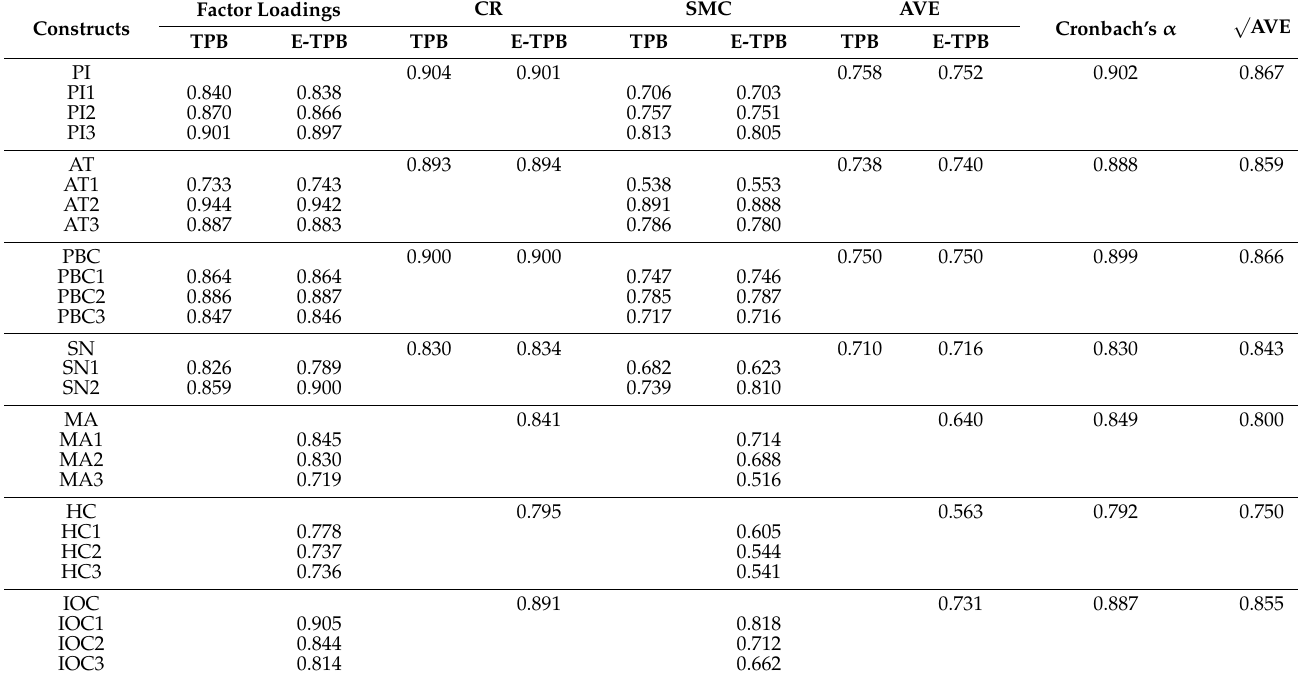
Table 3. Reliability and validity analysis.